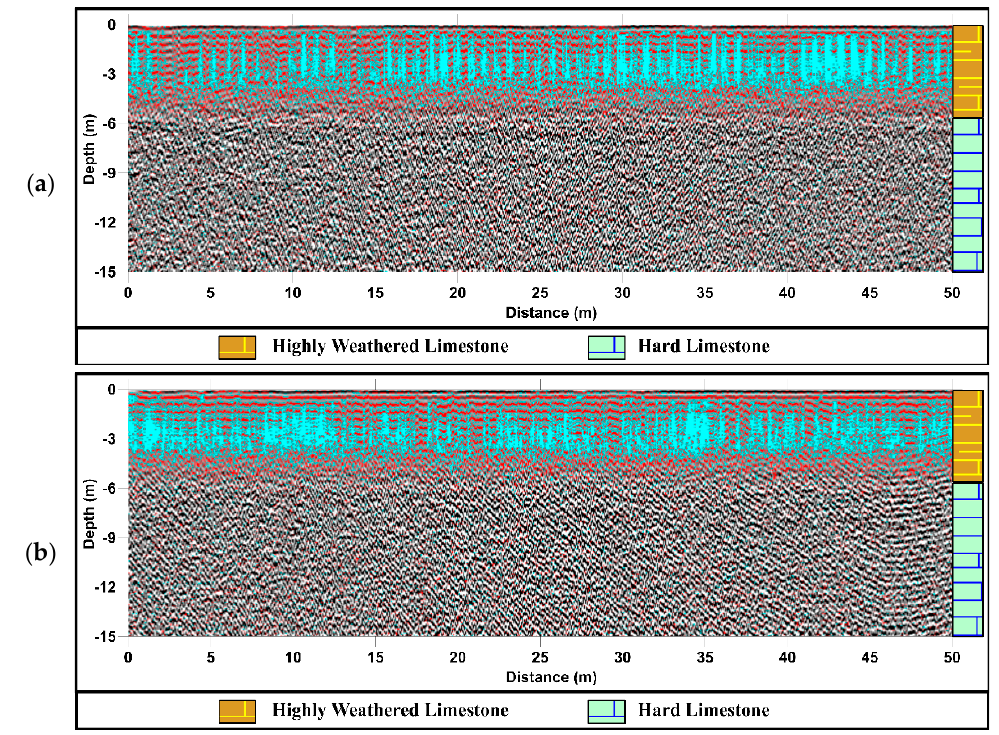
Figure 10. Samples of GPR records: ( a ) GPR-01 and ( b ) GPR-02. Investigating the behavior of the gathered plotted curves of resistivity data introduce a preliminary impression of the apparent resistivity distribution through the investigated site, which displayed two types of QH and KH resistivity curves through the investigated site and considered a straight reference on the approximate resistivity homogeneity through the study area, as shown in Figure 11.